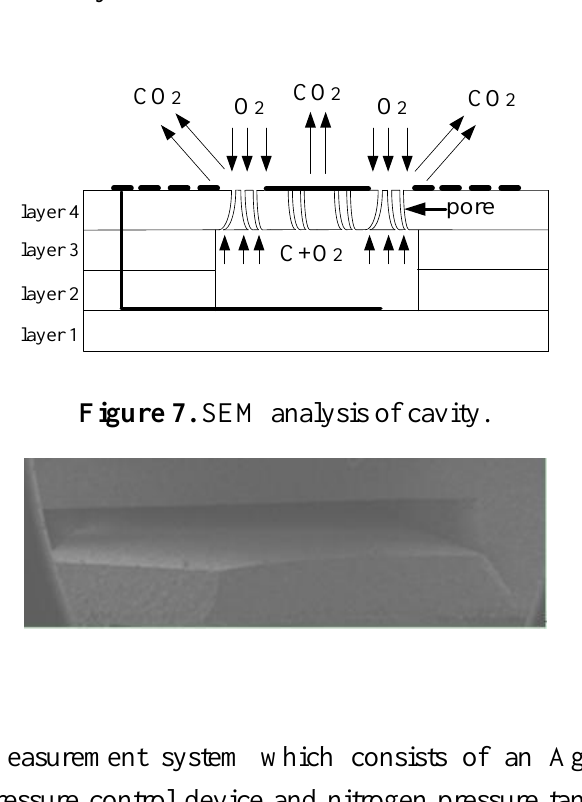
and spreads to air 2